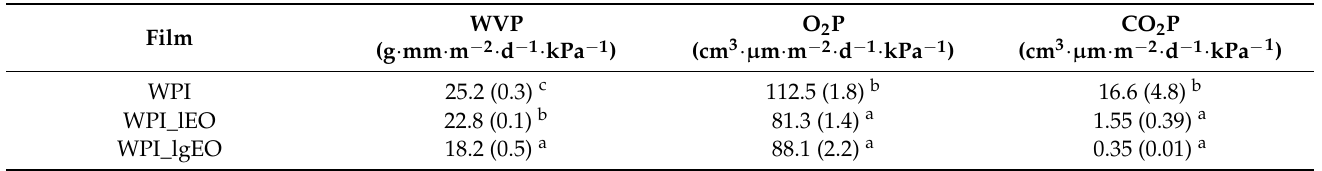
Table 2. Water vapour (WVP), oxygen (O 2 P) and carbon dioxide (CO 2 P) permeability of whey protein films with lemon (WPI + LEO) and lemongrass (WPI + LgEO) essential